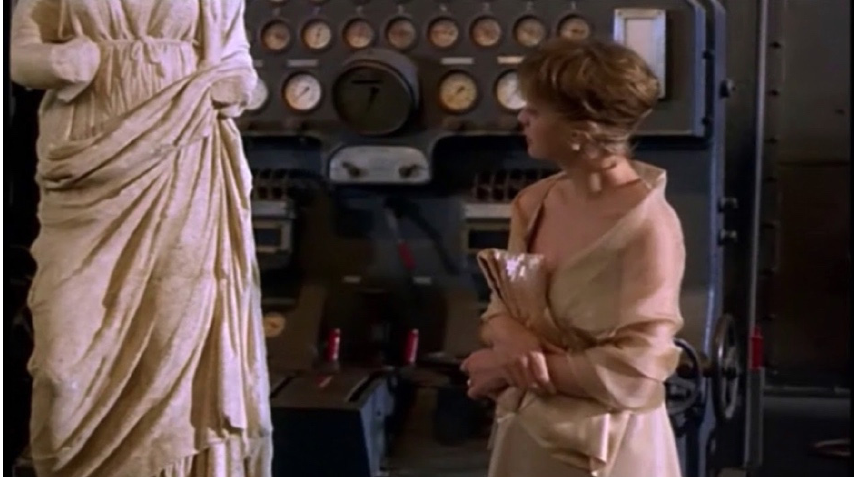
Figure 9. Scene from Le fate ignoranti ( His Secret Life , 2001) directed by Ferzan Özpetek.